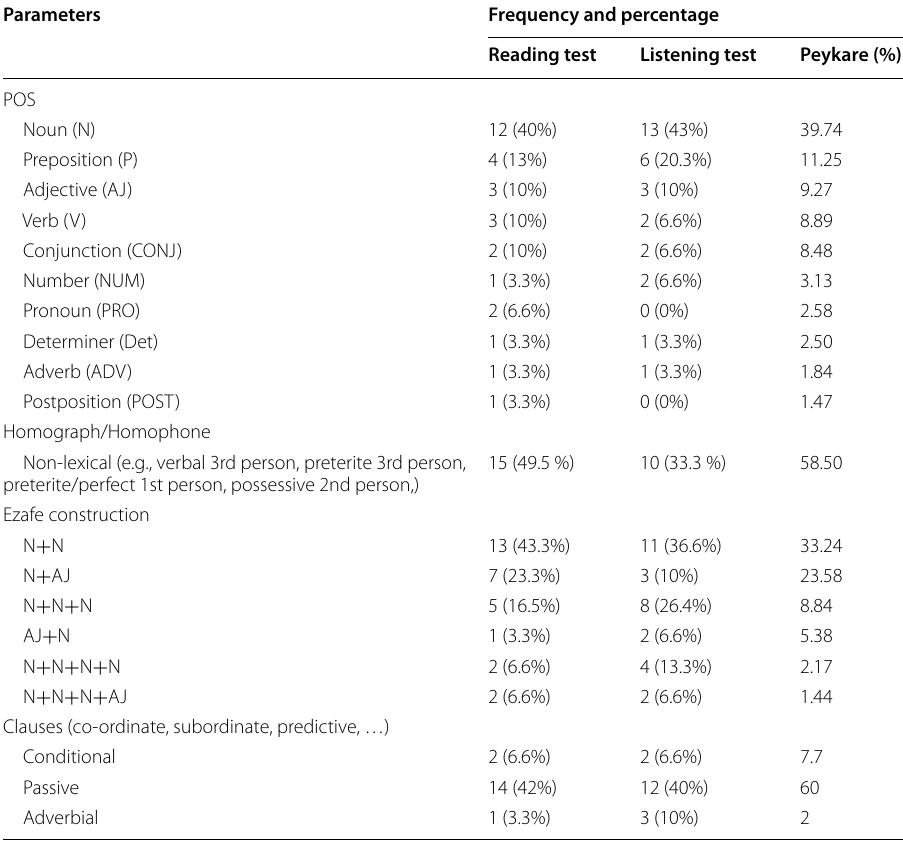
POS parts of speech